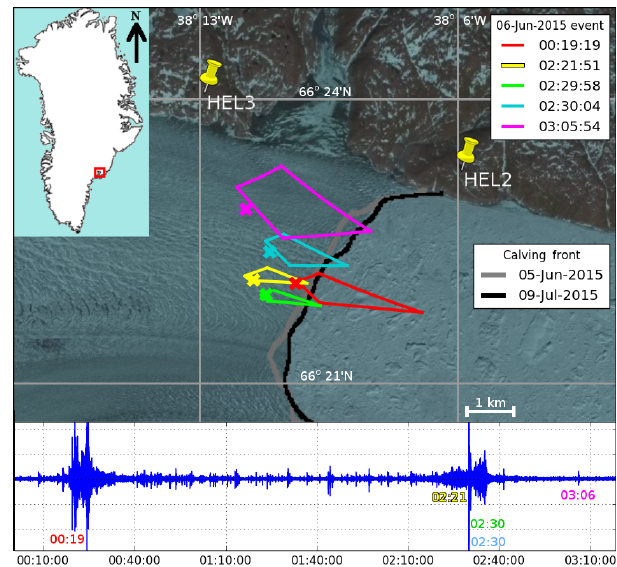
Figure 6. The calving event from 6 June 2015, with the localiza- tions (top panel) and the easting amplitudes of seismometer HEL1 (bottom panel) showing several sub-events. X indicates locations derived from using a grid search through a lattice of all points on the map with a fixed v eff = 1.20kms − 1 .